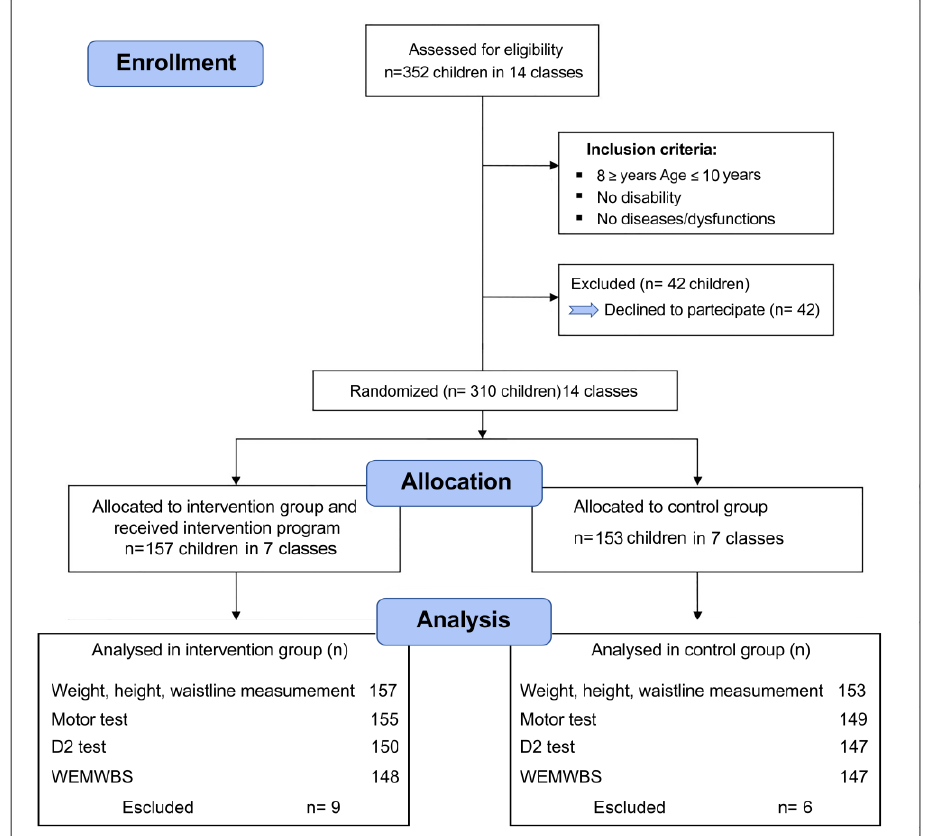
Figure 1. CONSORT flow diagram. WEMWB, Warwick – Edinburgh mental well-being test.